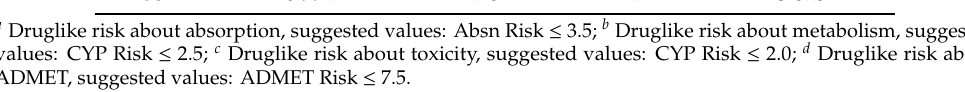
Table 2. Druglike Property Prediction of compound 6c .